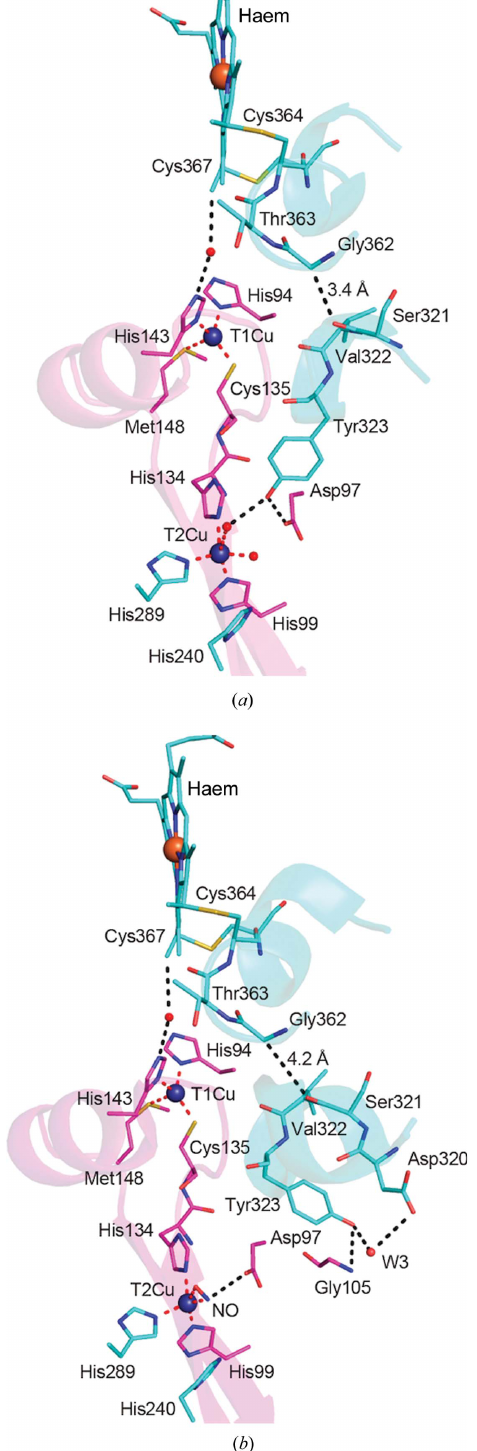
Figure 6 Possible electron-transfer routes from cytochrome to copper centres. ( a ) Wt Rp NiR and ( b ) Rp NiR–NO. The two adjacent monomers that form the catalytic centre are coloured magenta and cyan. Cu and Fe atoms are shown as blue and orange spheres, respectively, and water molecules as red small spheres. In the wt Rp NiR structures two electron-transfer routes appear to be feasible: a through-bond electron-transfer route that leads to Tyr323 via Gly362 and water-mediated electron transfer to T1Cu via His143. In the ligand-bound structures the water-mediated electron- transfer route to T1Cu